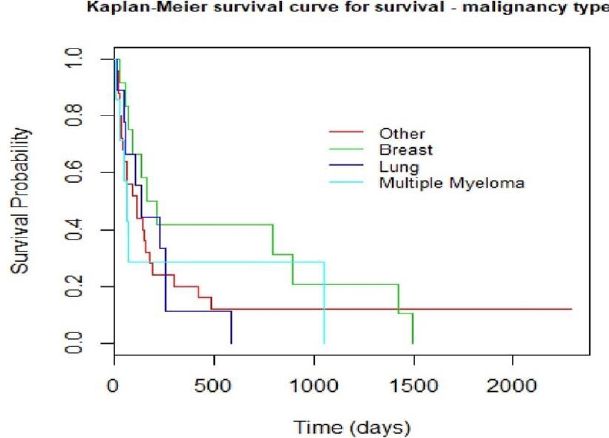
Figure 5. Kaplan – Meyer curve that compares survival among the most frequent malignancies in the study. p =